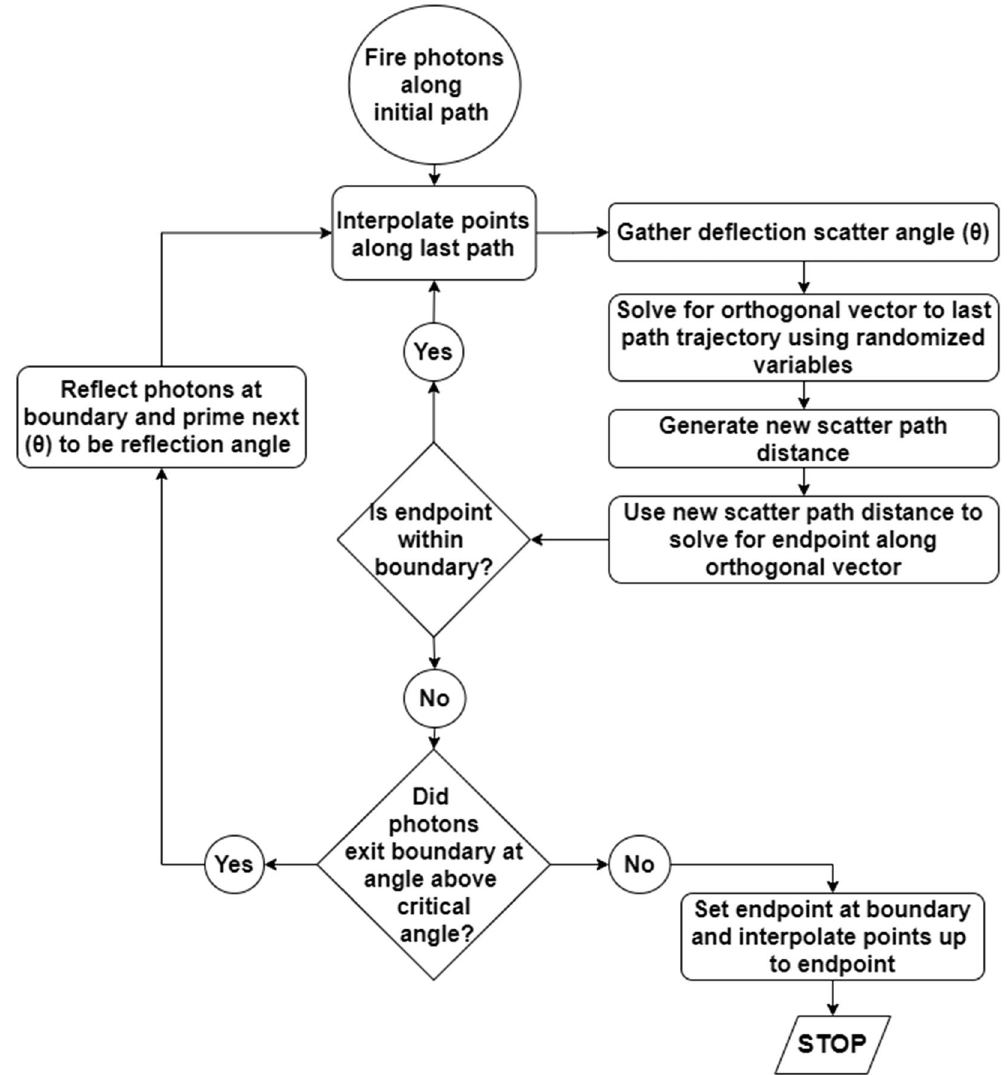
Figure 9. A description of the MC process for simulating light propagation through nerve tissue. Photon rays are initiated in their forward direction and are then scattered and attenuated in accordance with material properties for white matter. Scattering and attenuation are iterated until the photon packet has exited the nerve. Upon exiting the boundary condition, the angle of the packet’s last trajectory was relative to the nerve surface was checked, and if below the critical angle, was reflected and entered the scattering loop